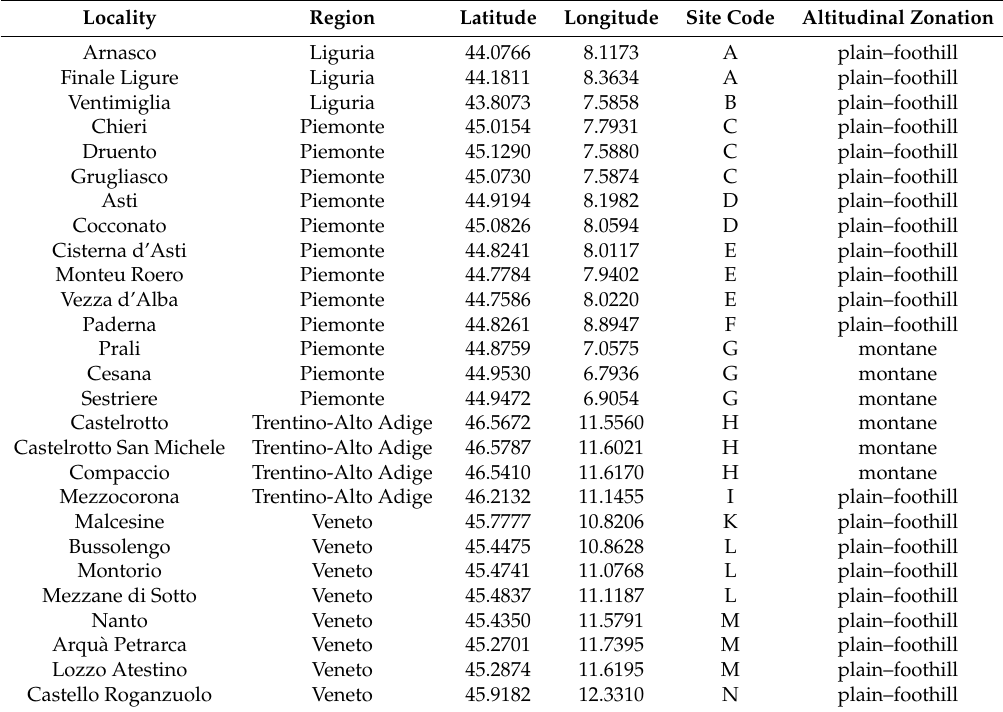
Table 1. Sites sampled for the presence of Verrallia aucta parasitizing adults of Philaenus spumarius and Neophilaenus campestris